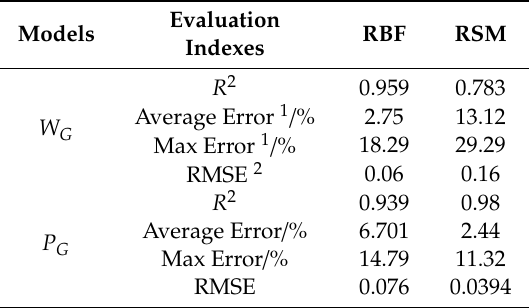
Table 3. Cross-validation error results of surrogate models.